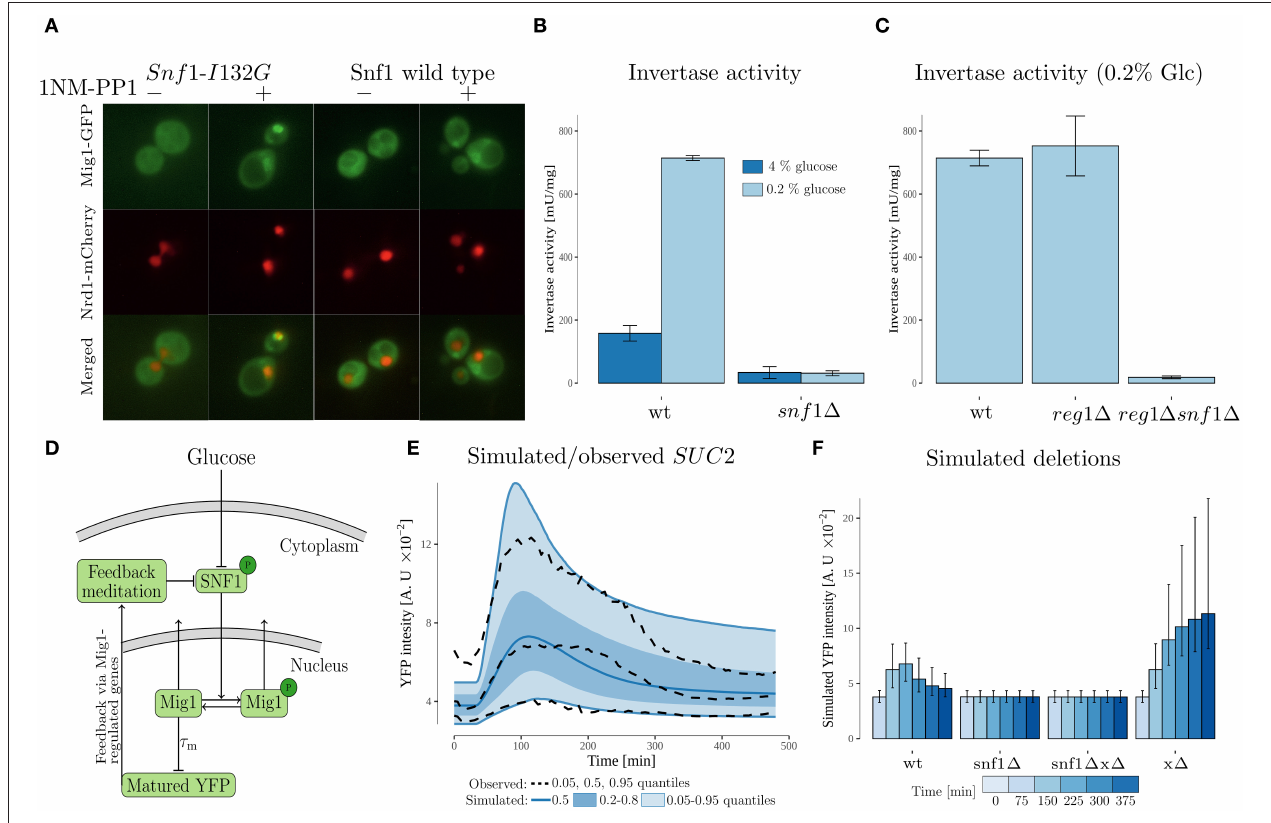
FIGURE 4 | Experimental data and modeling suggests SUC2 regulating feedback via SNF1 complex. (A) Cells with genomically integrated Mig1-GFP and Nrd1-mCherry fusions and expressing the wild type Snf1 or its analog-sensitive version, Snf1-I132G , were incubated in low (0.2%) glucose conditions with subsequent addition of 1NM-PP1 for 5 min prior to imaging. Images were enhanced using FiJi software for representation. (B) A read-out of invertase activity measured in cell lysates obtained from cultures pre-grown in 4% glucose medium, then incubated in 0.2% glucose conditions for 4 h. Error bars represent standard deviation. (C) A read-out of invertase activity measured in cell lysates obtained from cultures pre-grown in 4% glucose medium, then incubated in 0.2% glucose conditions for 4 h. Error bars represent standard deviation. (D) Feedback mediated model. The model, which is an extension of the cascade model ( Figure 3 ), proposes that the SUC2 expression decreases upon long term glucose starvation due to a feedback acting on the phosphorylated SNF1-complex ( SNF 1 p ). The maturation time of the promoter SUC 2 -YFP (measured output) was represented by a time-delay. The Mig1 nuclear export was represented by a SNF 1 p dependent sigmoid function. (E) Simulated and observed SUC2 expression. The simulated data was obtained by simulating 10,000 cells from the feedback mediated model. (F) Simulated deletions obtained by simulating 10,000 cells for each case from the feedback mediated model. Simulated intensity was sampled at discrete time-points. Error bars represent the 0.20 and 0.80 quantiles within the simulated single cell